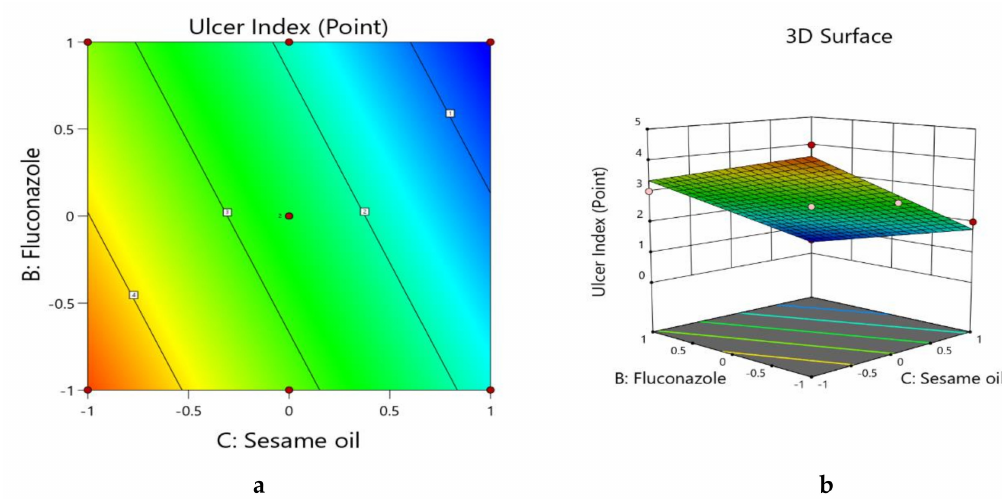
Figure 5. ( a ) Contour plot showing the interactions of the sesame oil and fluconazole on the ulcer index of the FS-NTF. ( b ) Three-dimensional surface plot showing the interactions of the sesame oil and fluconazole on the ulcer index of the